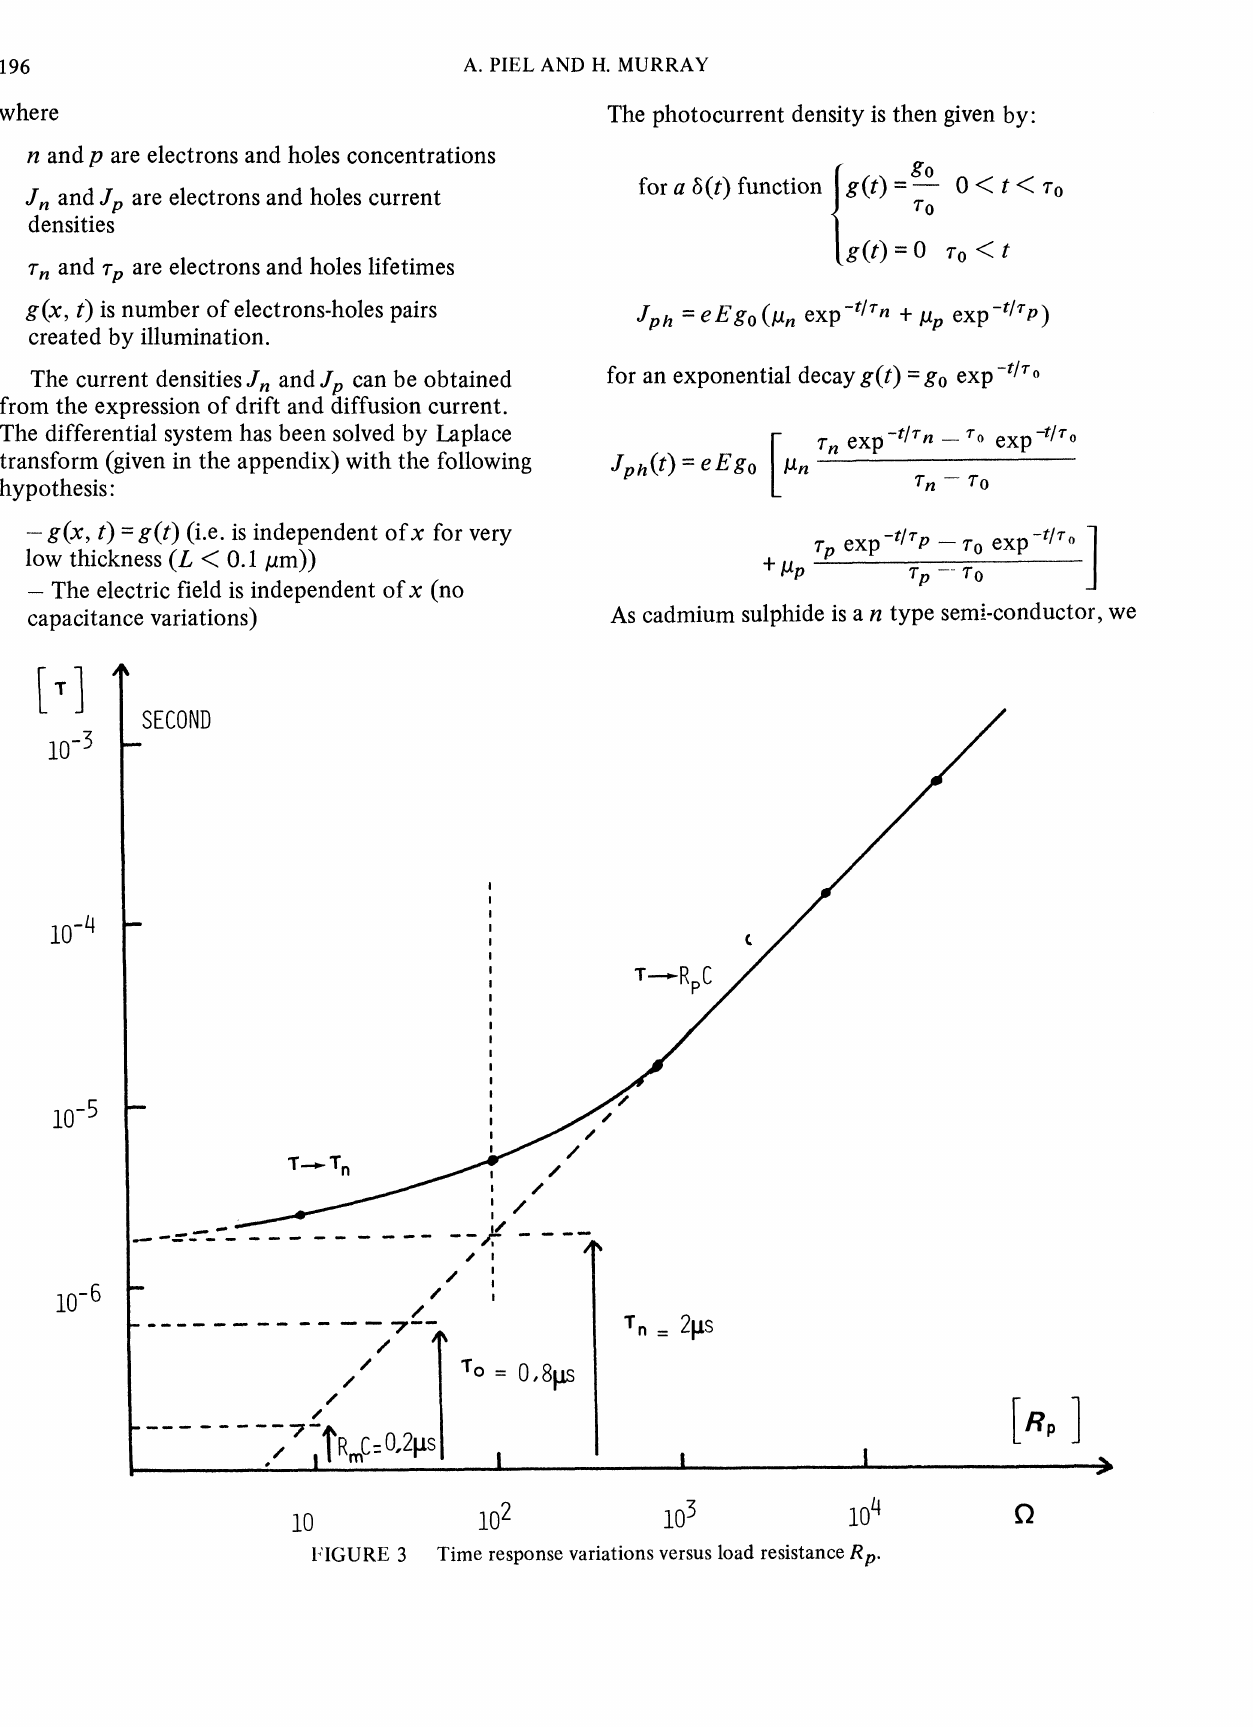
FIGURE 3 Time response variations versus load resistance